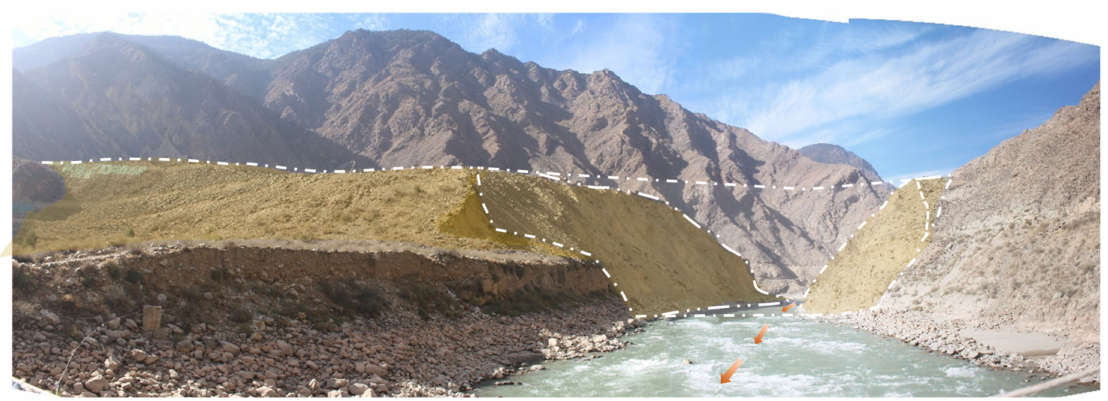
Figure 4. Geometry of GD landslide